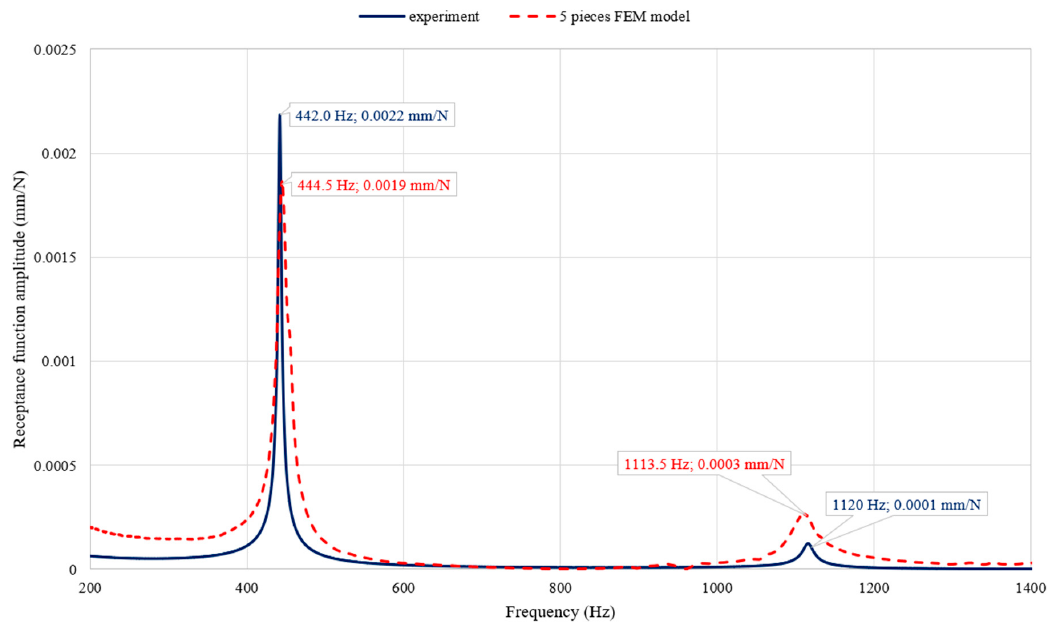
Figure 9. Comparison of the selected receptance function determined by calculation and experimentally.